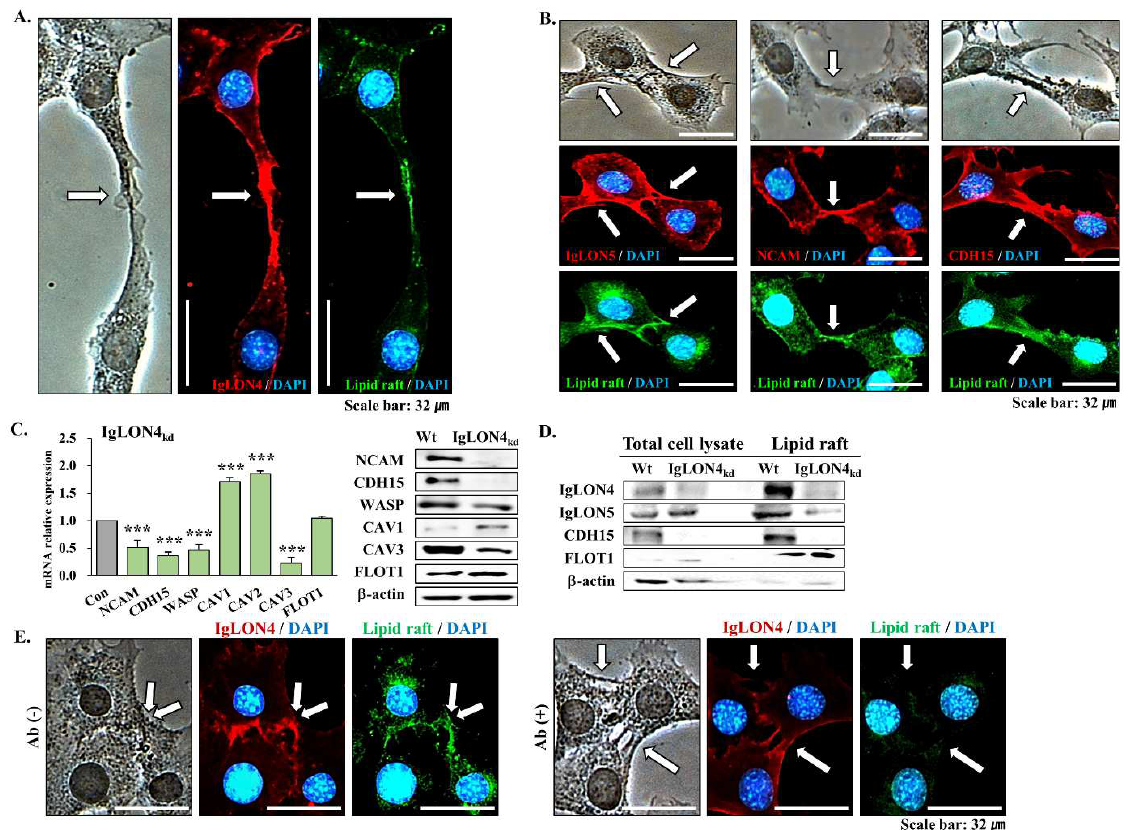
Figure 5. Locations of IgLON4 protein and lipid rafts on membranes, and the inhibitory effects of IgLON4 mRNA and protein on lipid raft during myoblast differentiation: ( A ) Locations of IgLON4 protein and lipid rafts as determined by immunocytochemistry on DD2. ( B ) Locations of IgLON5, NCAM, and CDH15 proteins and lipid rafts as determined by immunocytochemistry on DD2. ( C ) mRNA and protein expressions of NCAM, CDH15, WASP, CAV1, CAV2, CAV3, and FLOT1 in Wt and IgLON4 kd C2C12 myoblasts on DD2 as determined by real-time RT-PCR and Western blot analysis. ( D ) Extraction of lipid rafts from Wt and IgLON4 kd C2C12 myoblasts on DD2, and the protein expressions of IgLON4, IgLON5, CDH15, and FLOT1 by Western blot analysis. FLOT1 and -actin were used as markers of lipid rafts and total cell lysates, respectively. ( E ) Locations of IgLON4 protein and lipid rafts in C2C12 myoblasts treated with or without IgLON4 antibody as determined by immunocytochemistry on DD2. Wt indicates transfection with a scrambled vector. Lipid rafts were labeled green using cholera toxin and IgLON4, IgLON5, NCAM, and CDH15 were labeled red using Alexa Fluor 594. Real-time PCR results were normalized to each control (con, before differentiation) and analyzed by t-test. Means ± SDs (n ≥ 3). * p < 0.05, ** p < 0.01, *** p < 0.001.